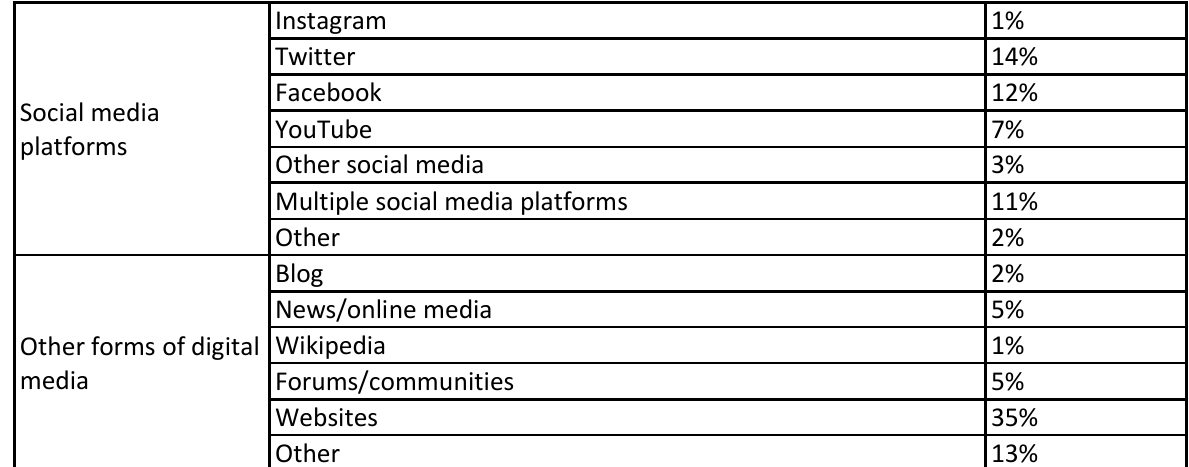
Table 1. Platforms analyzed (n = 100).